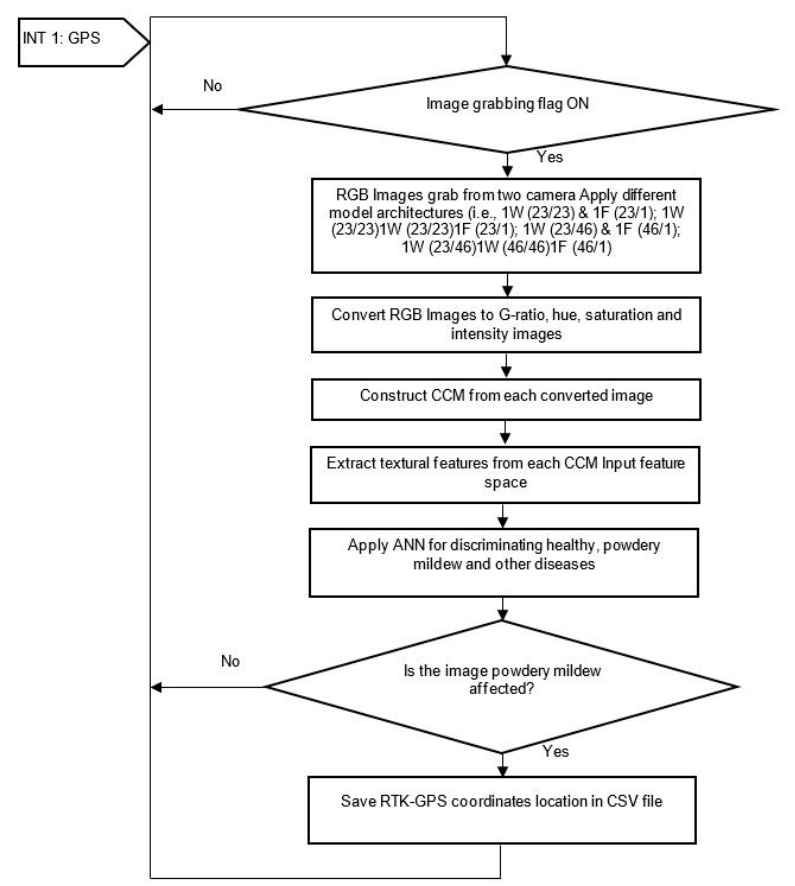
Figure 5. Flow chart of real-time strawberry powdery mildew disease detection algorithm.